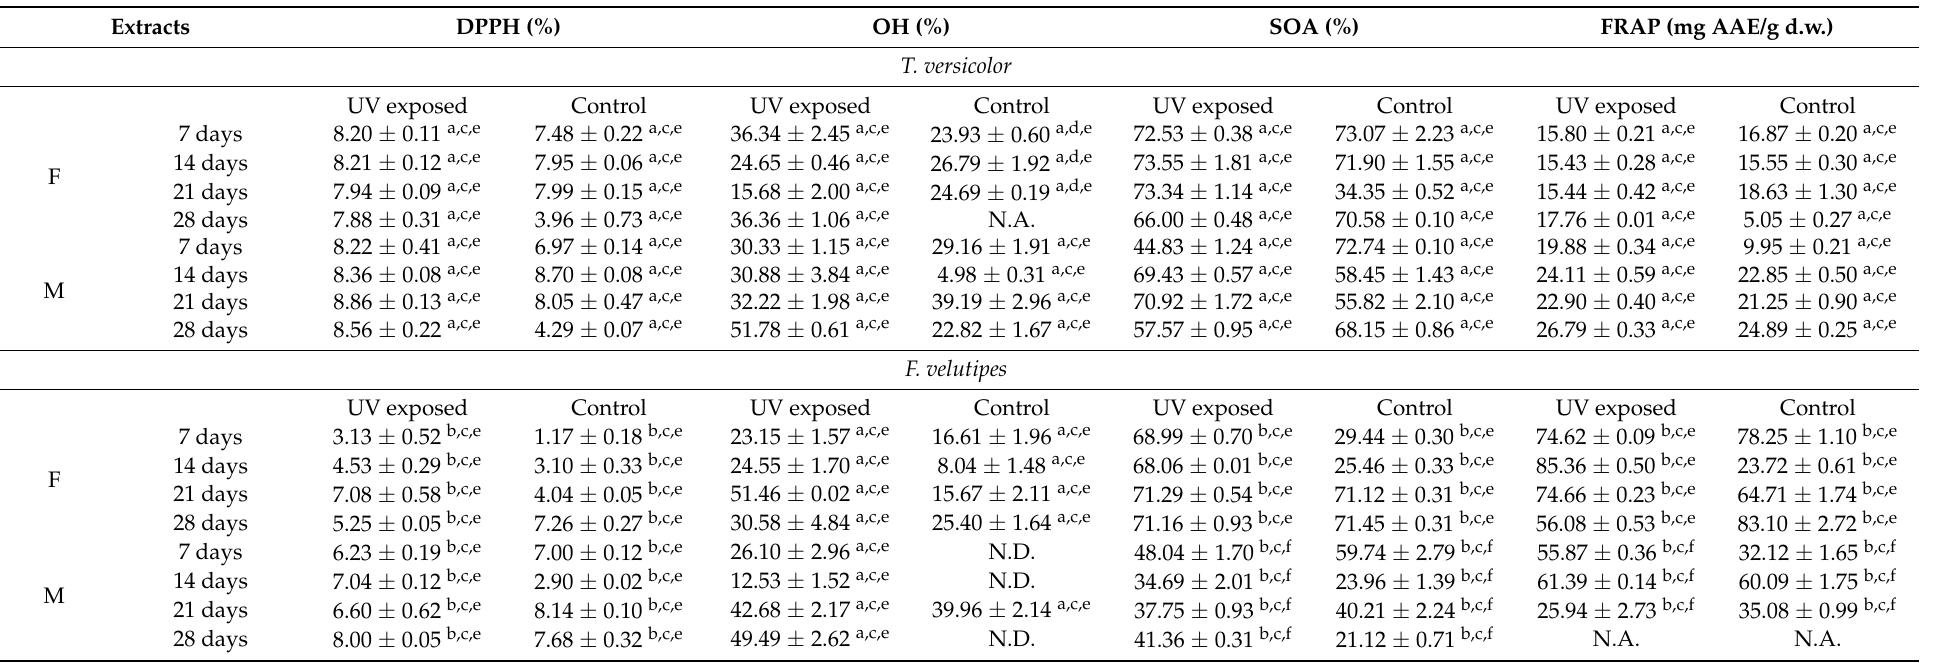
Table 3. AO activity of EtOH extracts of T. versicolor and F. velutipes